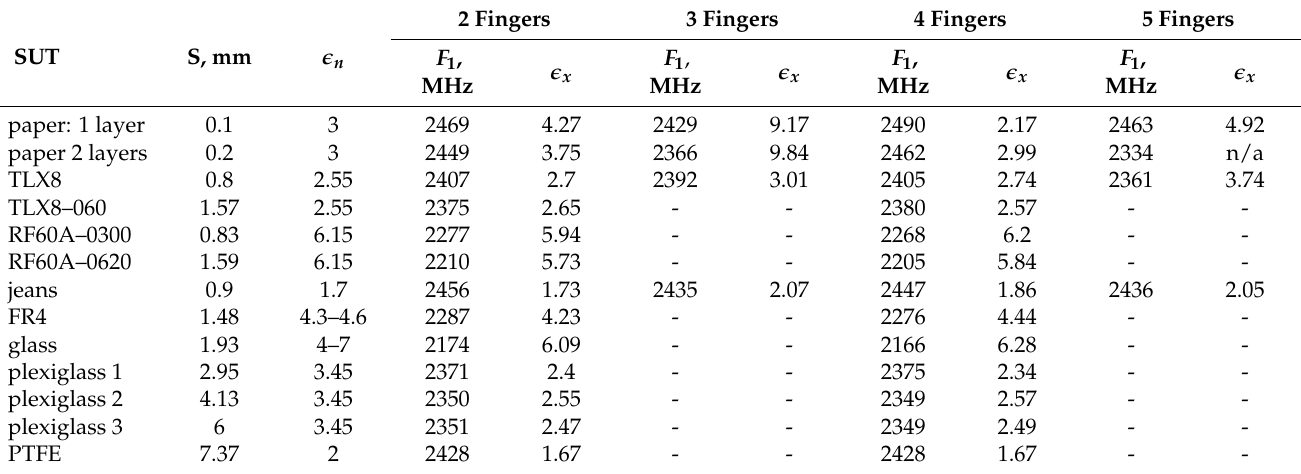
Table 6. Measurements of the impact of the four finger configurations.